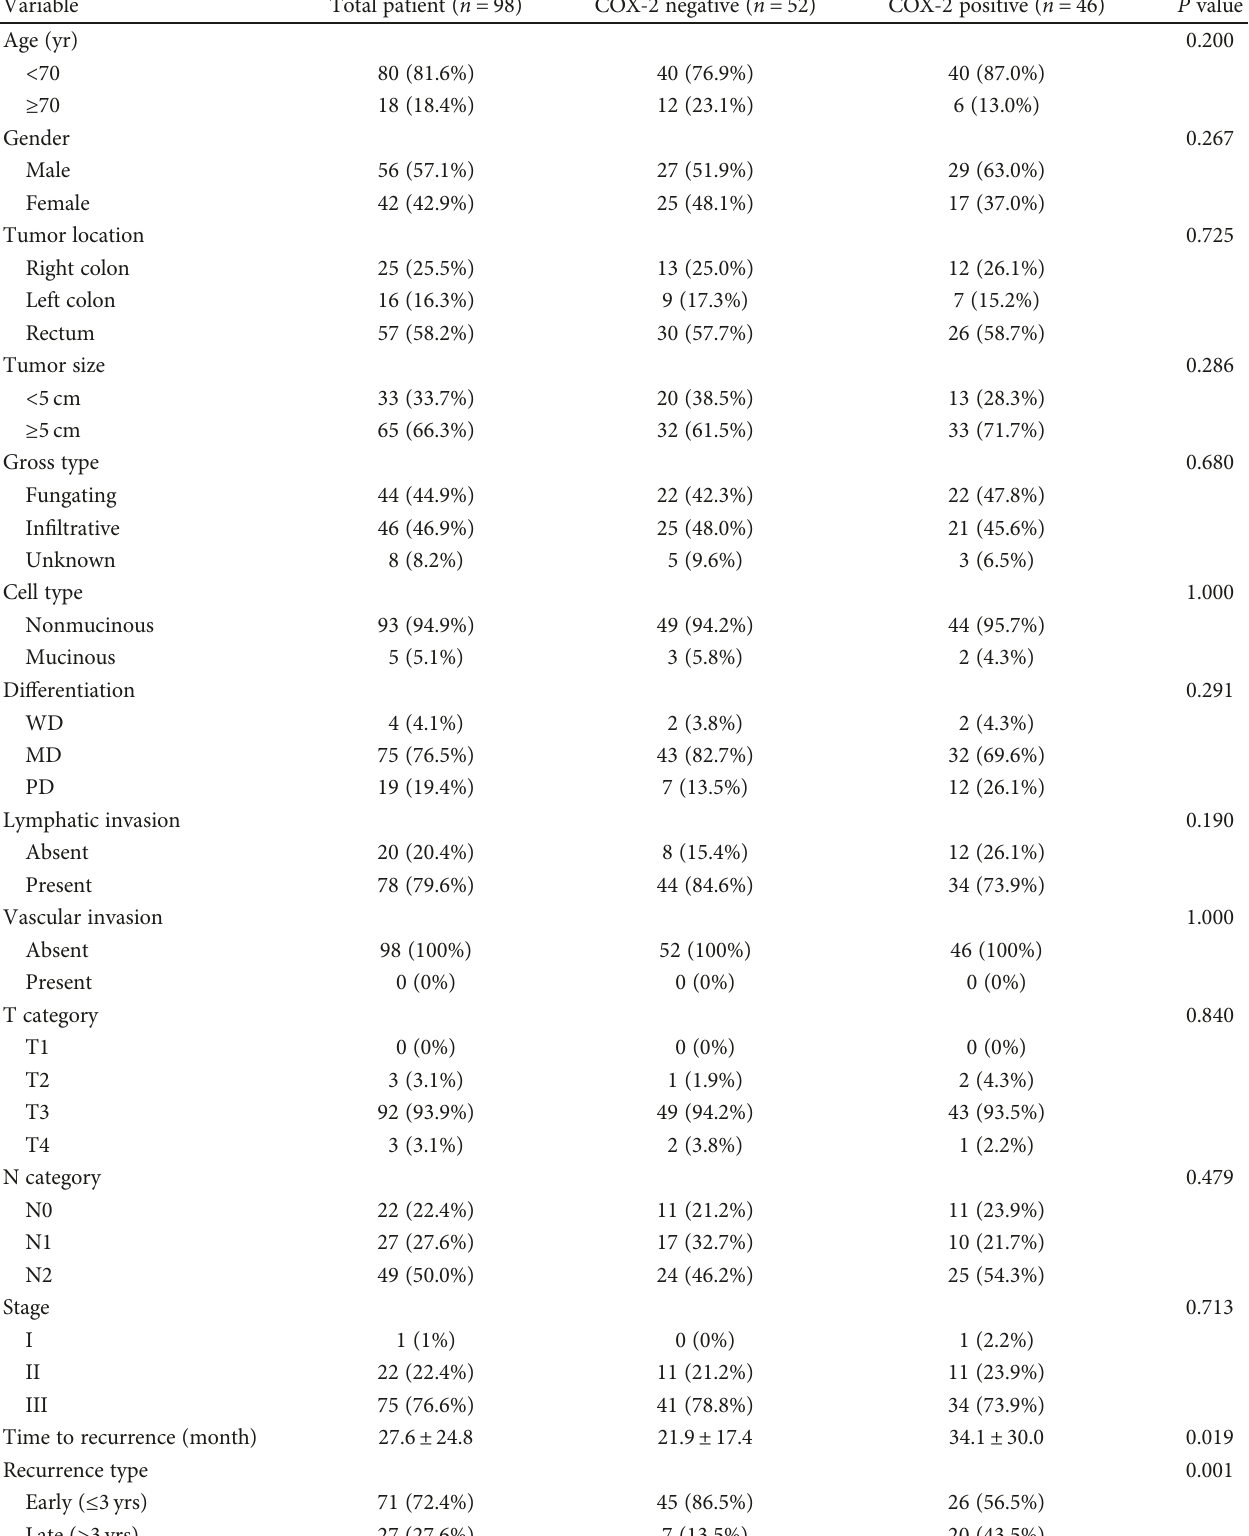
Table 2: Clinical and pathological characteristics according to COX-2 expression in patients with